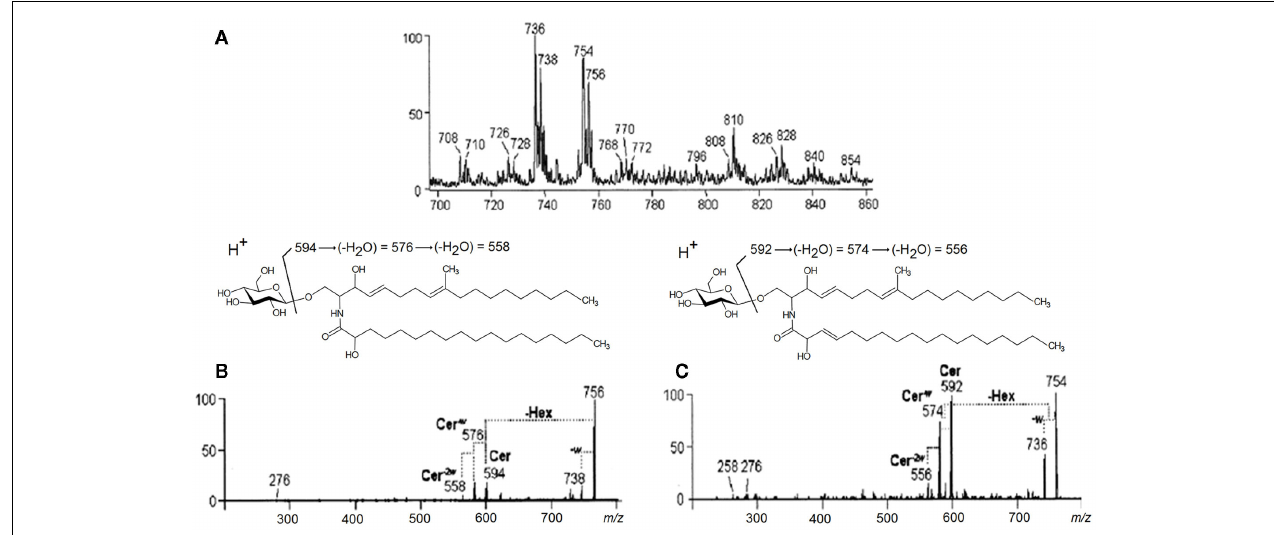
FIGURE 4 | Positive ESI-MS [M + H] + analysis of the GlcCer species of C. gloeosporioides . (A) MS 1 spectrum (B) and (C) ESI-MS2 of the ion species m/z 756 and 754, observed in (A) . Cer, ceramide; Hex, hexose; w, water.